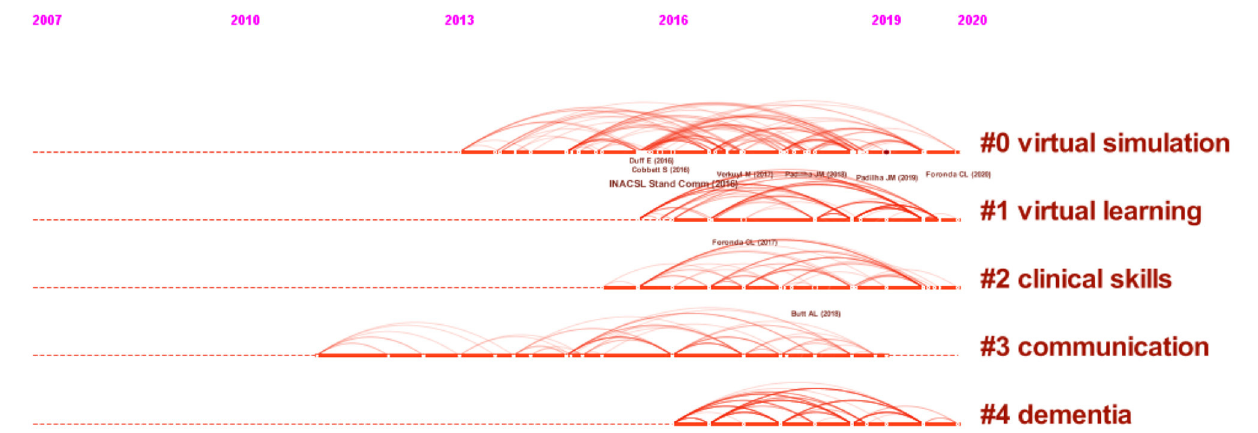
FIGURE 8 | Co-cited references timeline map of publications on the application of VR in nursing from 2012 to 2021. The cited literature is represented by the node on the timeline on the left side of the image. The citation link between documents is represented by curved connecting lines. The clustering label of the co-cited literature may be found on the right side of the image. The stronger the clustering strength, the higher the label position.